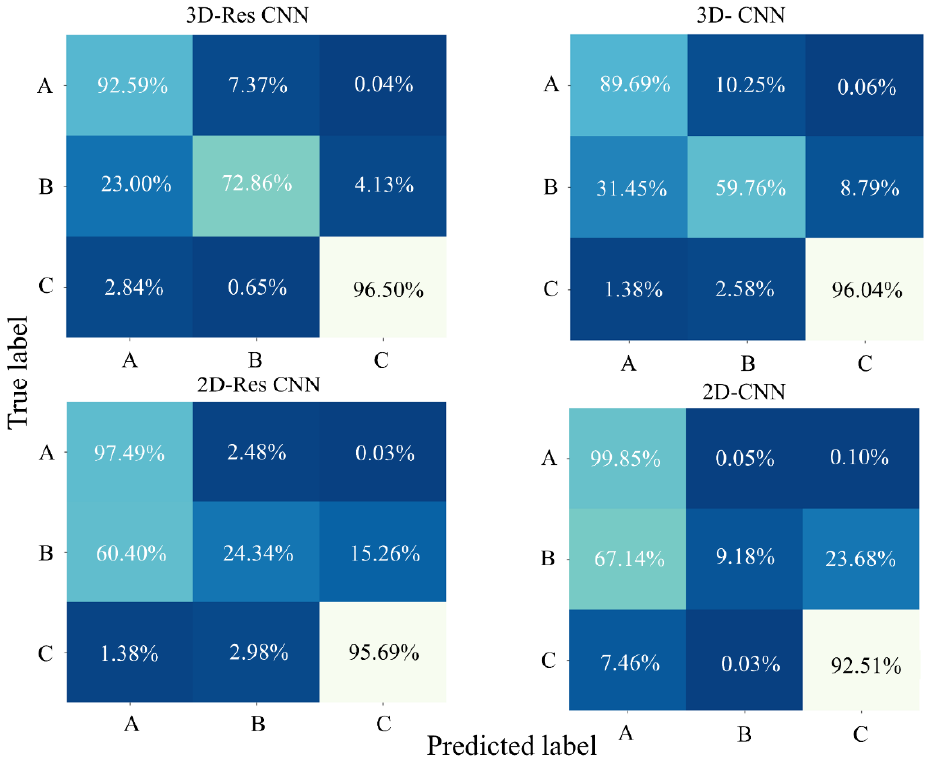
Figure 13. Confusion matrices for the three tree categories using different models, where A, B, and C respectively represent broad-leaved trees, early infected, and late infected pine trees.